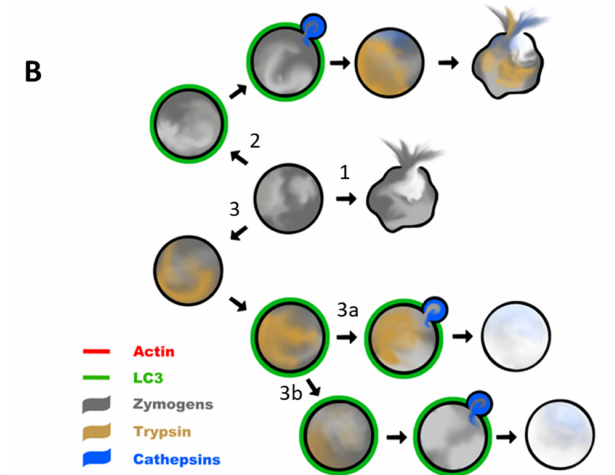
Figure 2. Simplified diagram illustrating hypothetical processes involving physiological compound exocytosis and excessive compound exocytosis leading to the formation of a large endocytic vacuole followed by its actination, LC3 conjugation, and trypsinogen activation. The opacity of the grey colour reflects the concentration of zymogens. The red colour represents polymerised actin, green colour indicates LC3 conjugation, blue colour indicates lysosomal cathepsins and dark yellow colour reflects intraorganellar activation of trypsinogen (formation of trypsin). ( A ) Early events involv- ing formation, actination, and trafficking of post-exocytic structures and endocytic vacuoles. ( Aa ) Illustrates exocytosis and post-exocytic events in physiological conditions (mediated by moderate stimulation with physiological secretagogues). During a physiological response, only a few secretory granules participate in the compound exocytosis. The small volume of the post-exocytic structure allows nearly complete release of the zymogens into the lumen. Signals driving exocytosis are limited in amplitude and duration; actination of the post-exocytic structures is sufficiently fast to prevent excessive fusion. The small vacuole is trafficked away from the secretory region and disassembled. ( Ab ) Represents excessive compound exocytosis and formation of a large endocytic vacuole. These events are initiated by large concentrations of secretagogues or bile acids. Signals driving exocytosis (particularly Ca 2+ signals) are strong and persistent. Actination of the post-exocytic organelle is not sufficiently fast and consequently a large number of secretory granules (up to 200) continue to fuse with the post-exocytic structure. The fusion pore closes trapping zymogens inside a large endocytic vacuole diluted by luminal fluid. Fusion of zymogen granules with the endocytic vacuole continues even after the closure of the fusion pore. The vacuole disconnects from the apical plasma membrane. The endocytic vacuole is finally completely actinated and fusion of secretory granules with the vacuole stops. The endocytic vacuole (containing a significant concentration of zymogens) is transported from the secretory region into the basolateral part of the cell and sheds its actin coat. ( B ) Illustration of the hypothetical evolution of the endocytic vacuole after it sheds actin (i.e., after the events shown in part Aa). Pathway 1 illustrates the putative process involving the rupture of an endocytic vacuole (before trypsinogen activation). Zymogens in this case are released into the cytosol and could potentially be activated in the cytosol. Pathway 2 demonstrates a putative role of LC3 conjugation, CASM/LNCA, and lysosomal hydrolases in activating trypsinogen with subsequent vac- uolar rupture and the release of trypsin into the cytosol. Such a pathway is likely to cause cell damage. Pathway 3a illustrates a putative protective role of CASM/LNCA against trypsin-induced damage. In this case, trypsinogen is activated (trypsin is formed) in the endocytic vacuole independently from LC3 conjugation; LC3 conjugation with the subsequent lysosomal fusion results in the destruction of the trypsin by lysosomal hydrolases. Pathway 3b. Illustrates another putative protective mechanism involving lysosomal fusion. In this case, lysosomes repair the vacuolar membrane preventing the rupture of the vacuole and the release of trypsin (or trypsinogen) into the cytosol. It is conceivable that both protective mechanisms (shown on 3a and 3b ) can operate